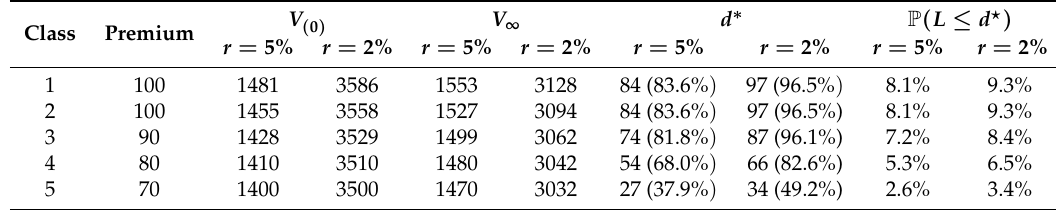
Table 3. Impact of the optimal reporting strategy, Exponential losses, λ = 8% and r = 5% or